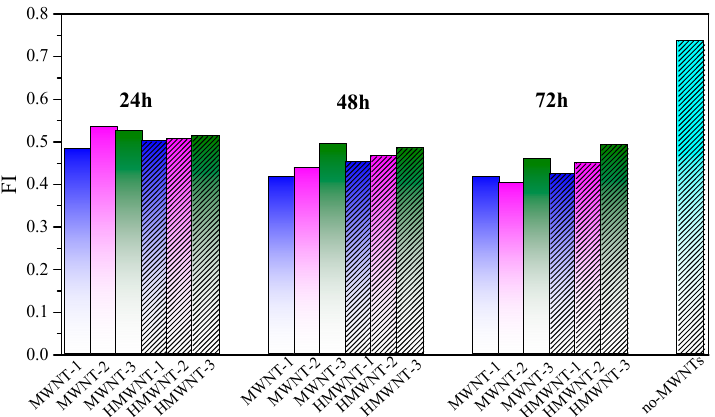
Figure 9. Changes in the florescence index (FI) for HA after adsorption on MWNTs and HMWNTs.